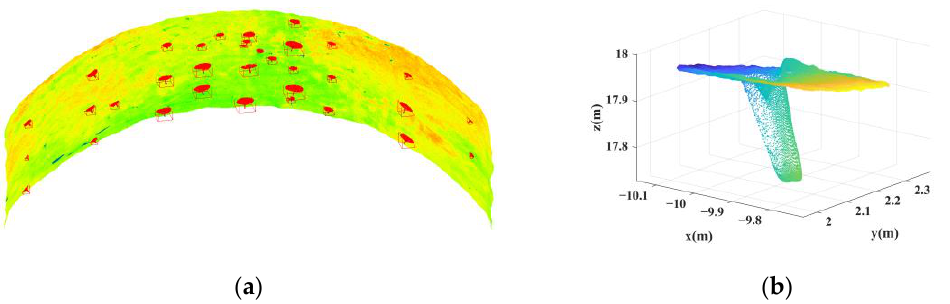
Figure 8. Precise screening results after clustering. ( a ) Clusters with anchor rod points. ( b ) A cluster containing anchor rod points.